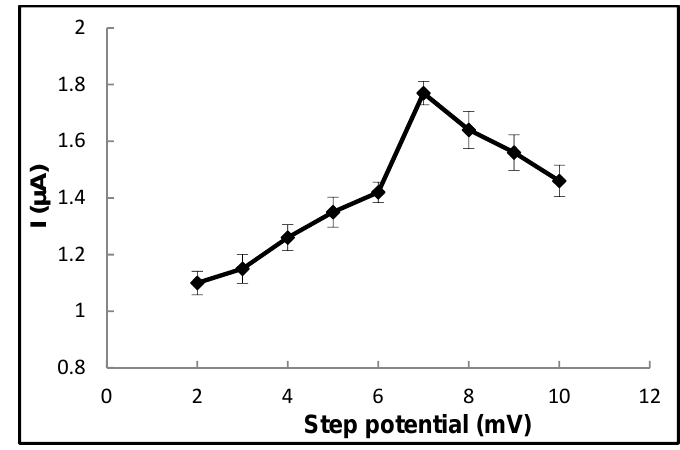
Figure 4. The influence of the step potential on the ferulic acid (50 ppm) oxidation peak current.Data are shown as the mean ± 1 SD and are derived from 3 independent